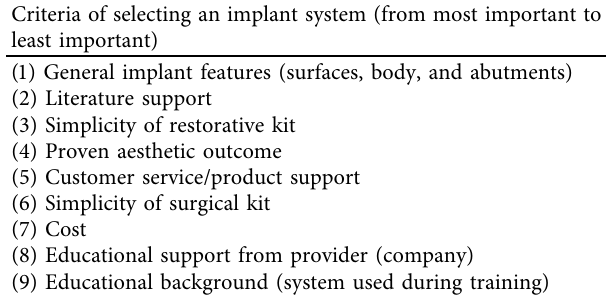
Table 3: The ranking of criteria when selecting an implant com- pany/system.